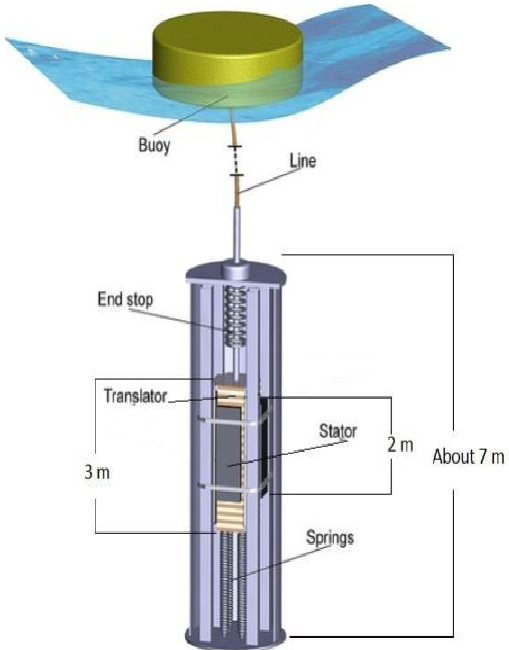
Fig. 1. UU-WEC, developed at Uppsala University